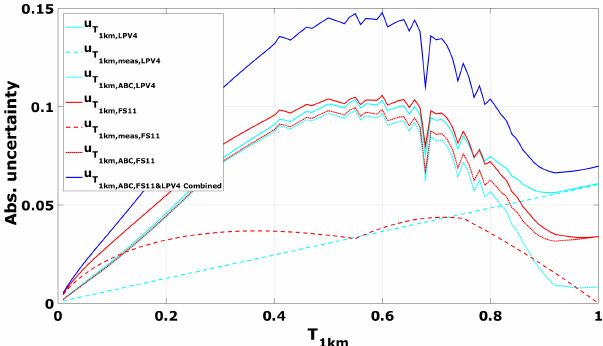
Figure 11. Absolute uncertainties of absorption- and broadband- corrected transmittance as in case of Sect. 3.1 measured by FS11 scatterometer and LPV4